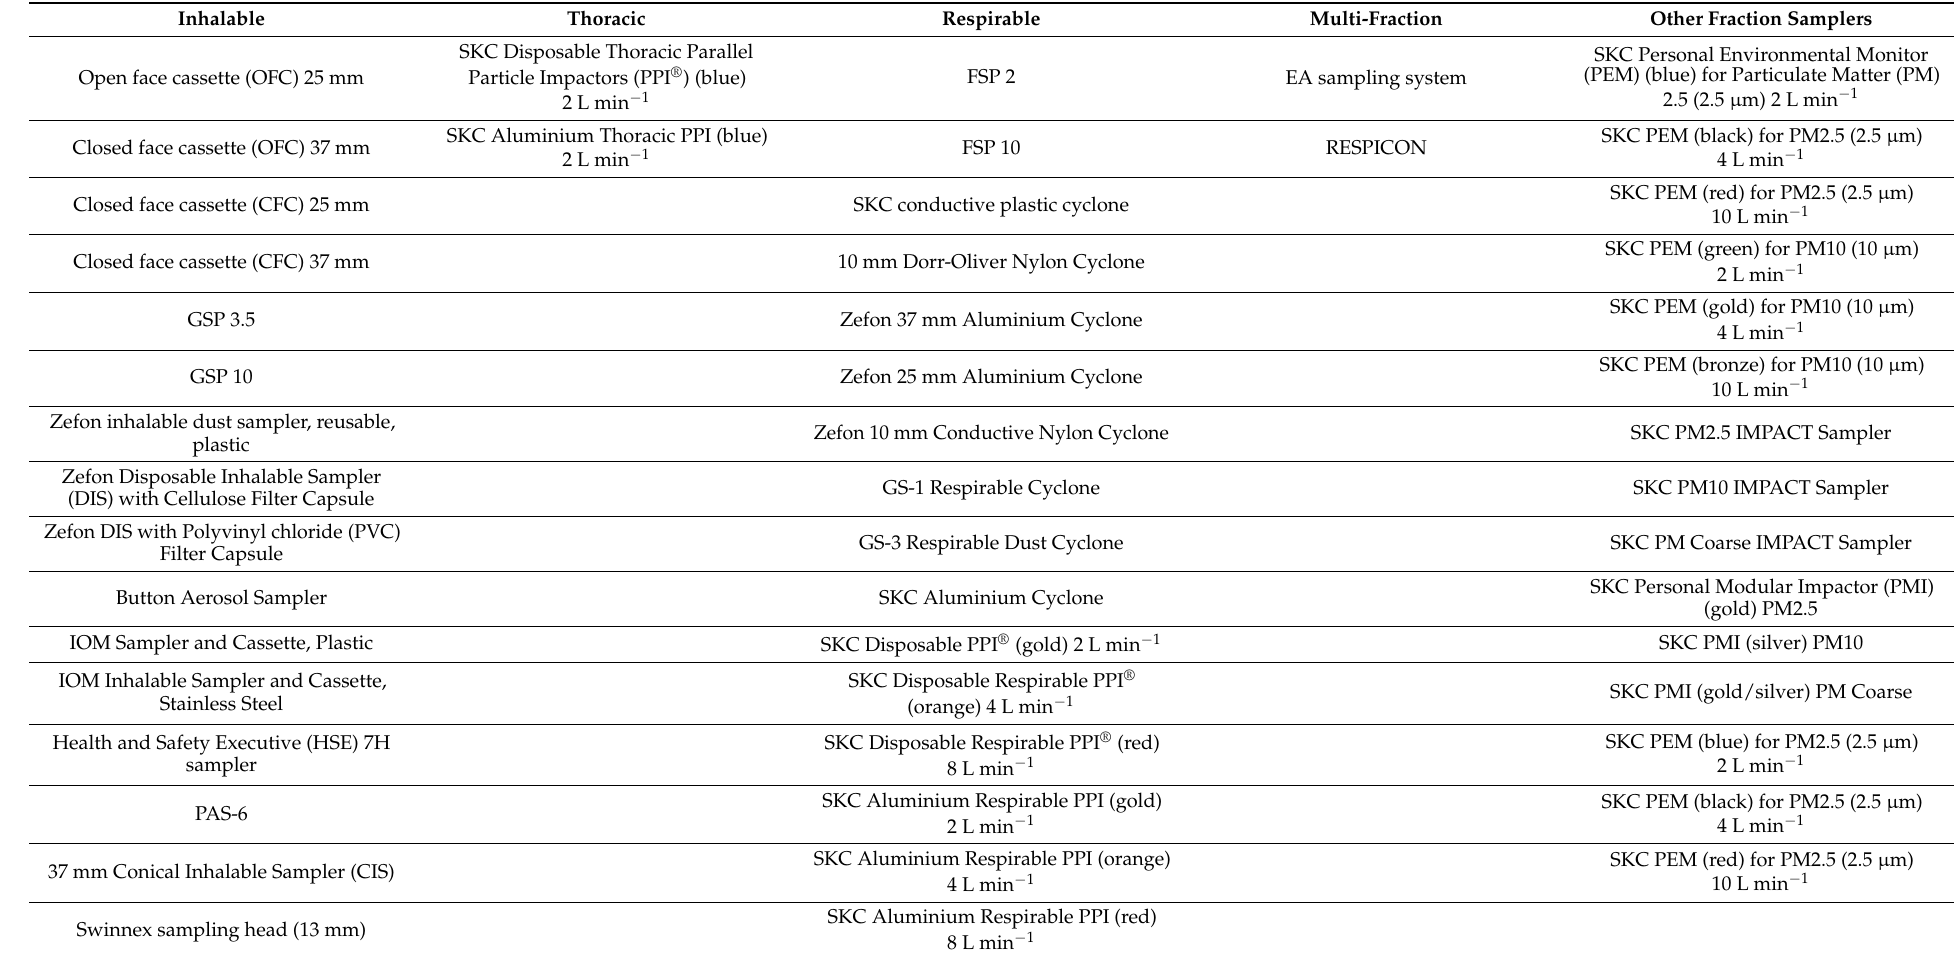
Table A1. List of samplers identified as being used by the metals industries (personal communication, S Verpaele).